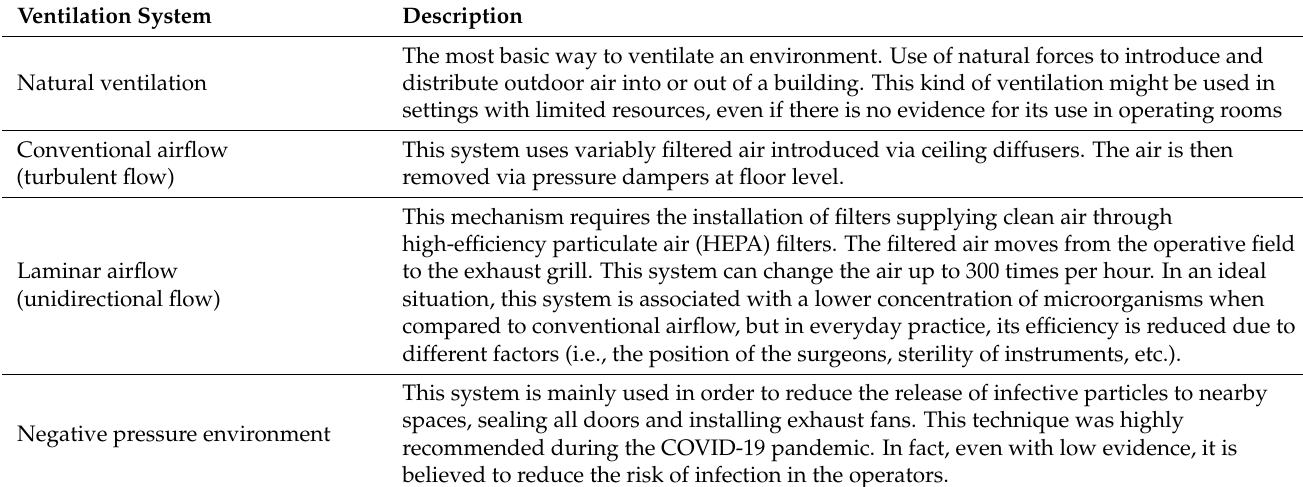
Table 4. Most common ventilation systems in the operating